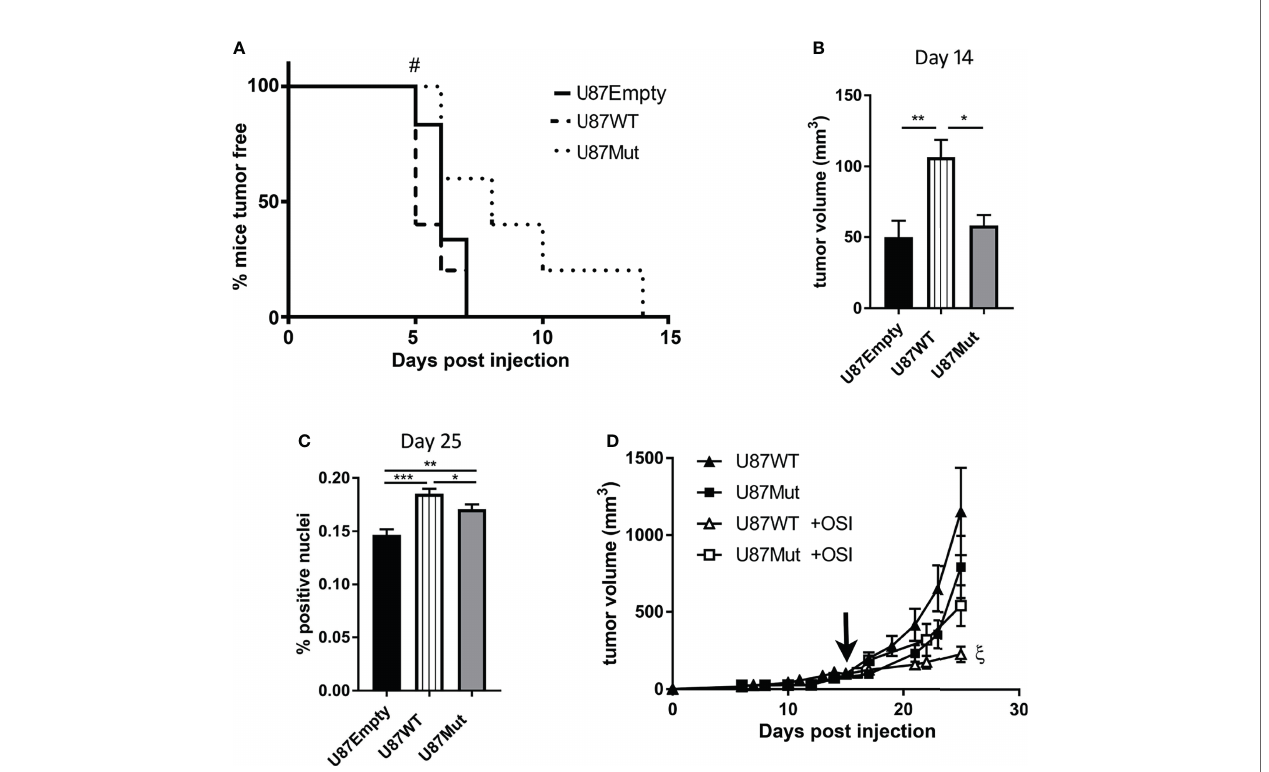
FIGURE 5 | Effects of IGF1R localization in glioblastoma xenografts. (A) Incidence and latency period of tumors developed by U87Empty ( n = 5), U87WT ( n = 5), and U87Mut ( n = 5) cells were recorded and plotted in a Kaplan – Meier curve (# p < 0.05, log-rank test). (B) Tumor growth: tumor volume was calculated for each developed tumor. The two longest perpendicular axes in the x/y planes were measured, and the volume was calculated 14 days after U87Empty, U87WT, or U87Mut cell injection. Values are presented as mean ± SD (* p < 0.05, ** p < 0.005, ANOVA, Tukey ’ s post-test). (C) Proliferation index in vivo . The mice were injected with BrdU 3 h before sacri fi ce. The tumor-positive nuclei were quanti fi ed. The results are expressed as mean ± SD (* p < 0.05, ** p < 0.005, *** p < 0.001, ANOVA, Tukey ’ s post-test). (D) The mice injected subcutaneously with U87WT or U87Mut clones were treated orally with OSI906 when the tumor volume reached 150 mm 3 (black arrow). The results are expressed as mean ± SD [ x p < 0.05 U87WT (closed triangles) vs . U87WT +OSI (open